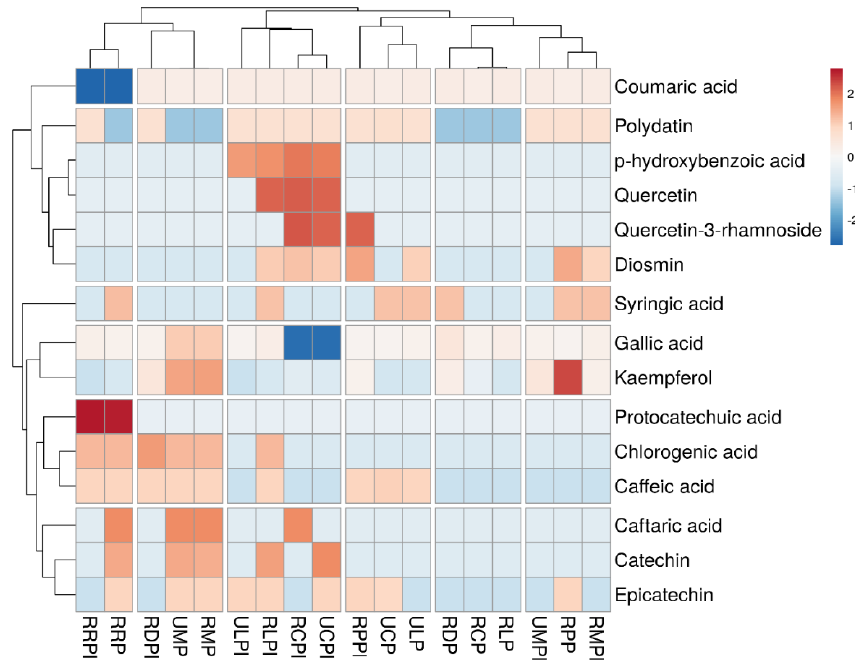
Figure 3. Heatmap showing “distribution and concentration” of quantified phenolic compounds (mg/g) in all banana samples. Red colour boxes indicating the higher concentration while blue colour boxes showing lower or zero concentration. Banana were presented with abbreviations. Ripe